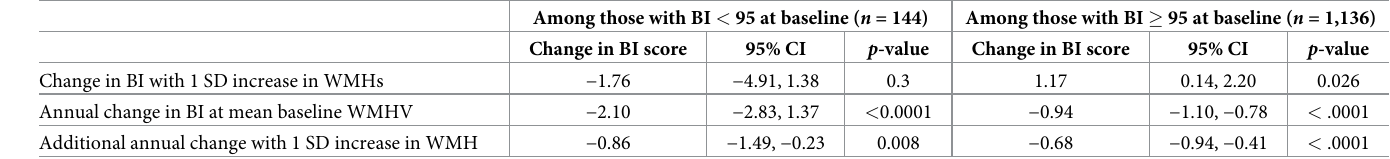
Table 4. Associations between whole brain WMHV and functional status stratified by baseline BI score, in adjusted models. Among those with BI < 95 at baseline ( n = 144) Among those with BI (cid:21) 95 at baseline ( n = 1,136) Change in BI score 95% CI p -value Change in BI score 95% CI p